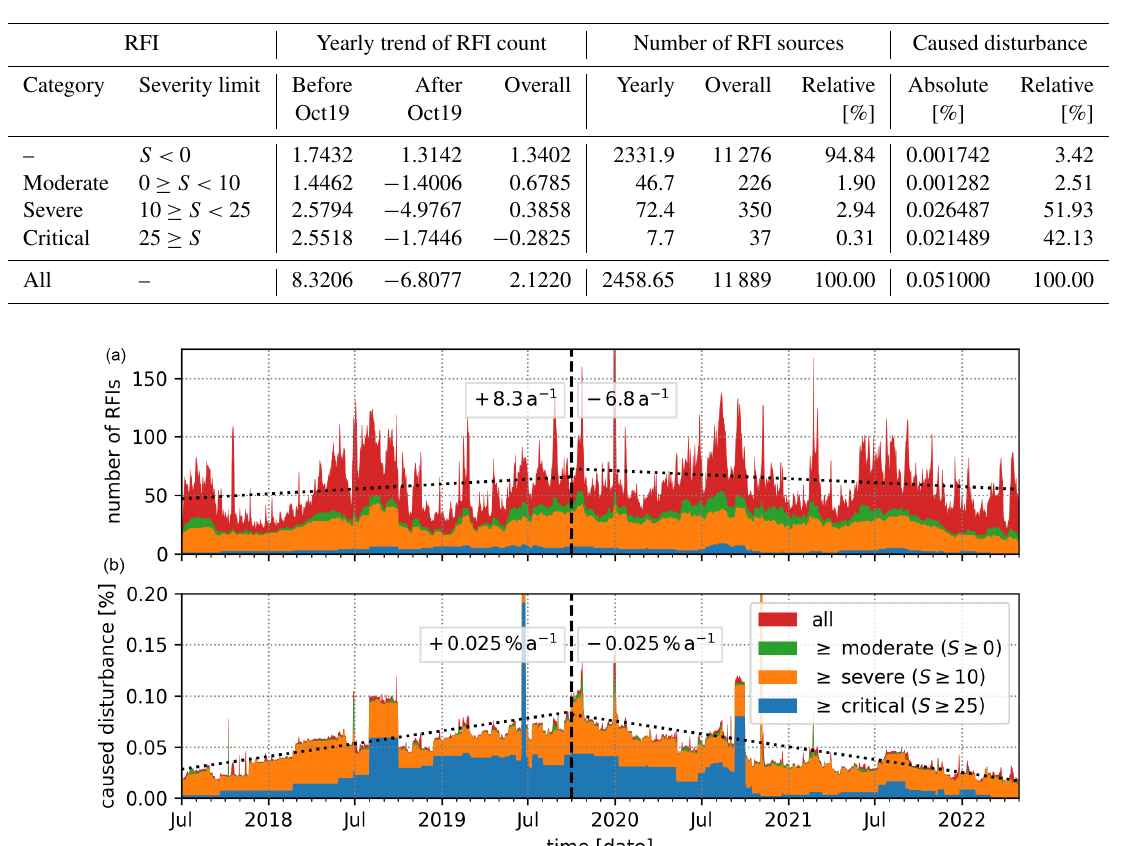
Figure 9. Daily timeline of detected RFI sources over the entire DWD radar network (18 sites) from July 2017 to May 2022. Each RFI active during a particular day is added to the displayed statistics for that day. Panel (a) contains the number of detected RFI sources, while panel (b) contains the percentage of caused disturbance. The caused disturbance is given relative to the total amount of expected rays (288 rays in one direction during a day at each elevation for each